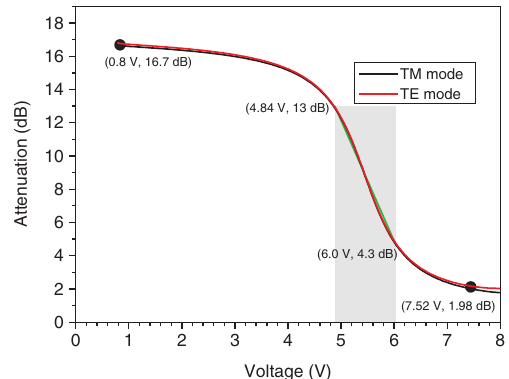
Figure 7: Attenuation of graphene-based polarization-insensitive optical modulator versus drive